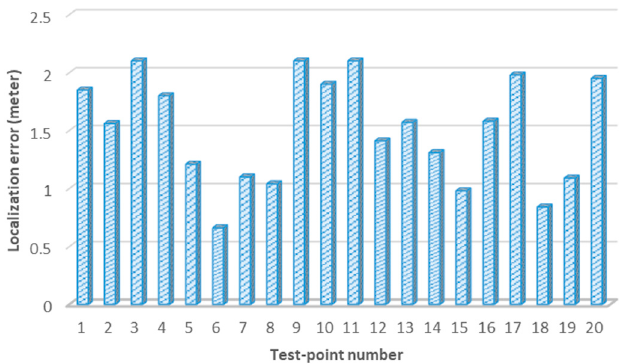
Figure 15. The localization error for 20 test points in the study room testbed.